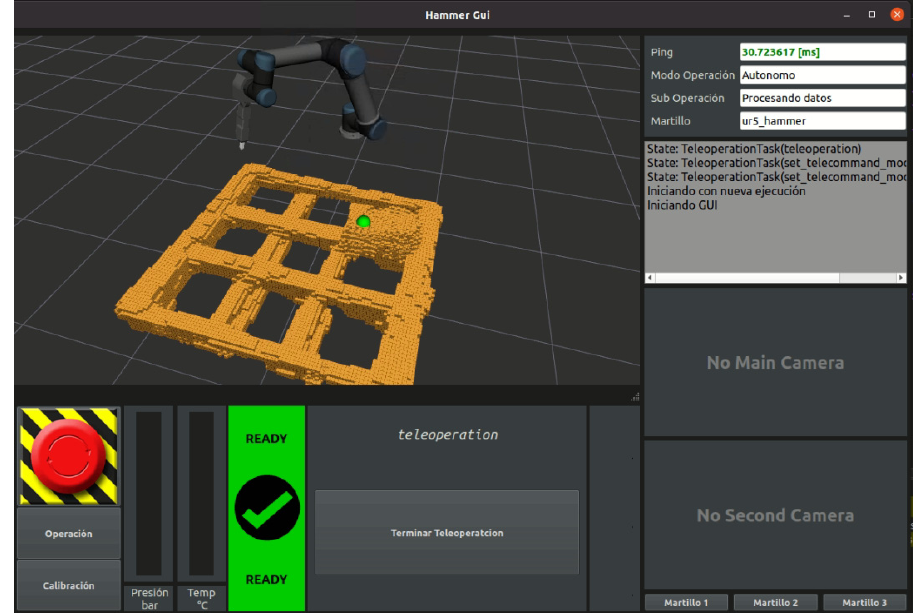
Figure 13. User interface. The yellow shows the visual output of the processing of the point clouds obtained by the sensors.